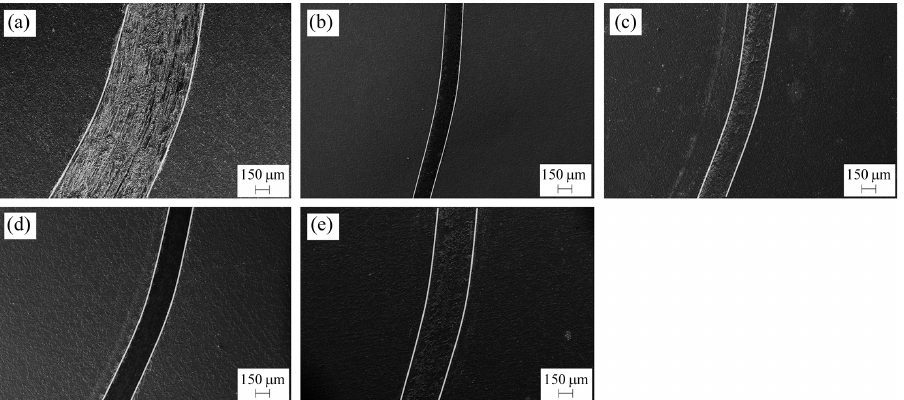
Figure 7: SEM images of the worn surfaces of the pure tita- nium specimens: (a) untreated, (b) Nit.600, (c) Nit.600 + CrN, (d) Nit.700, and (e) Nit.700 +